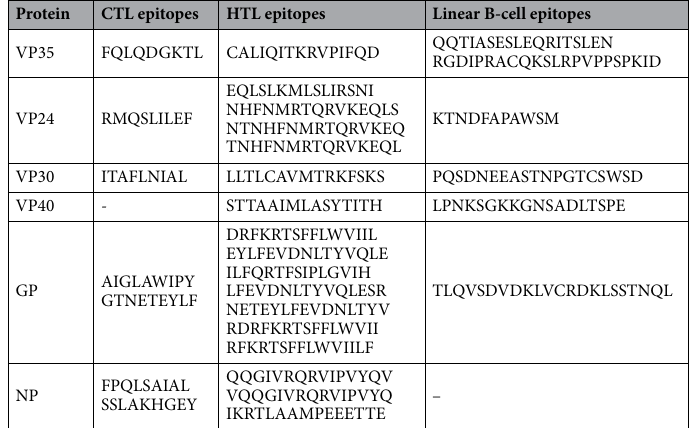
Table 2. A list of the epitopes that constitute the multi-epitope vaccine.